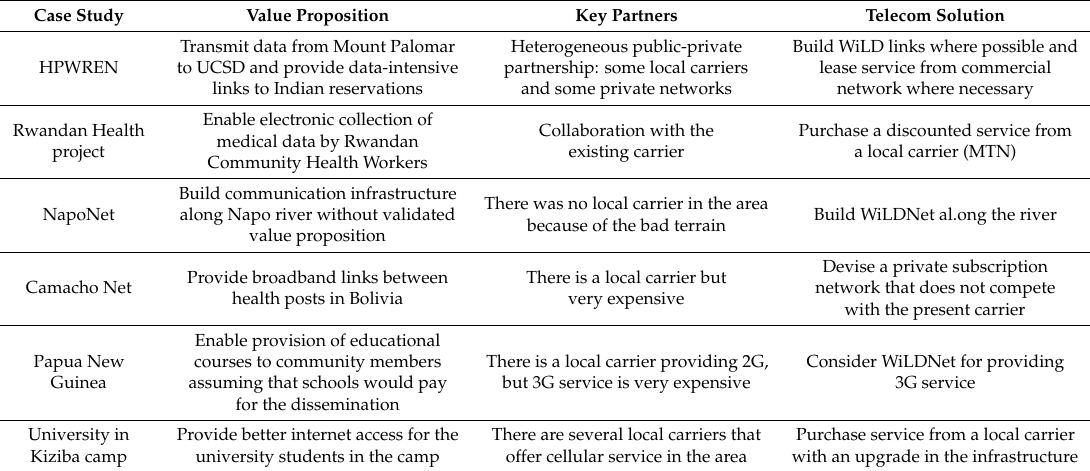
Table 1. Summary of the case